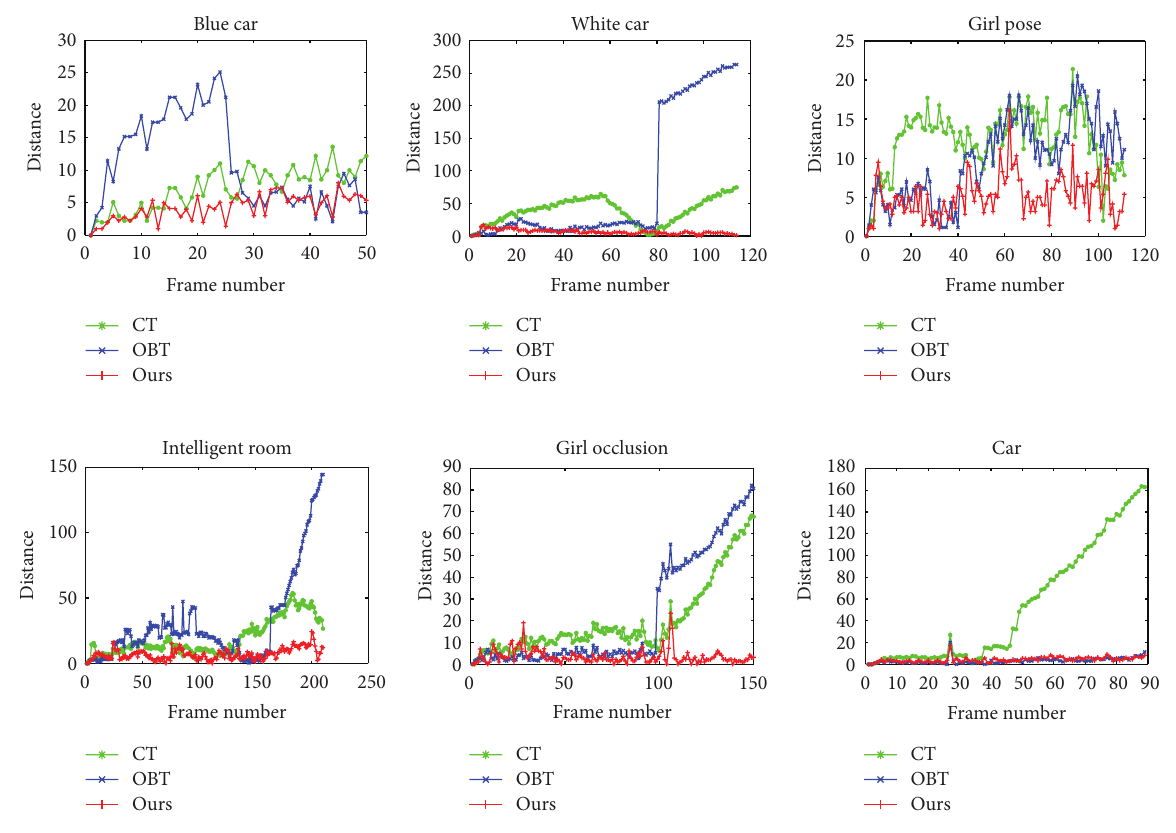
Figure 9: Results of